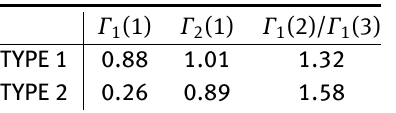
Table 2: Comparison of inclusion regions based on